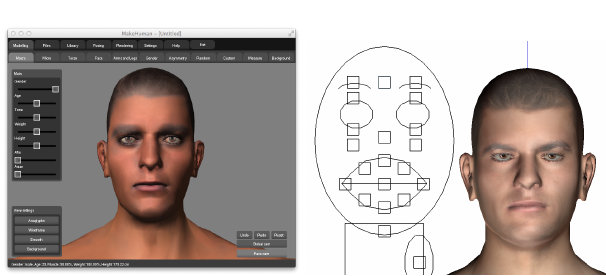
Figure 4. Left: the MakeHuman GUI. Right: the head mesh and the control rig imported in